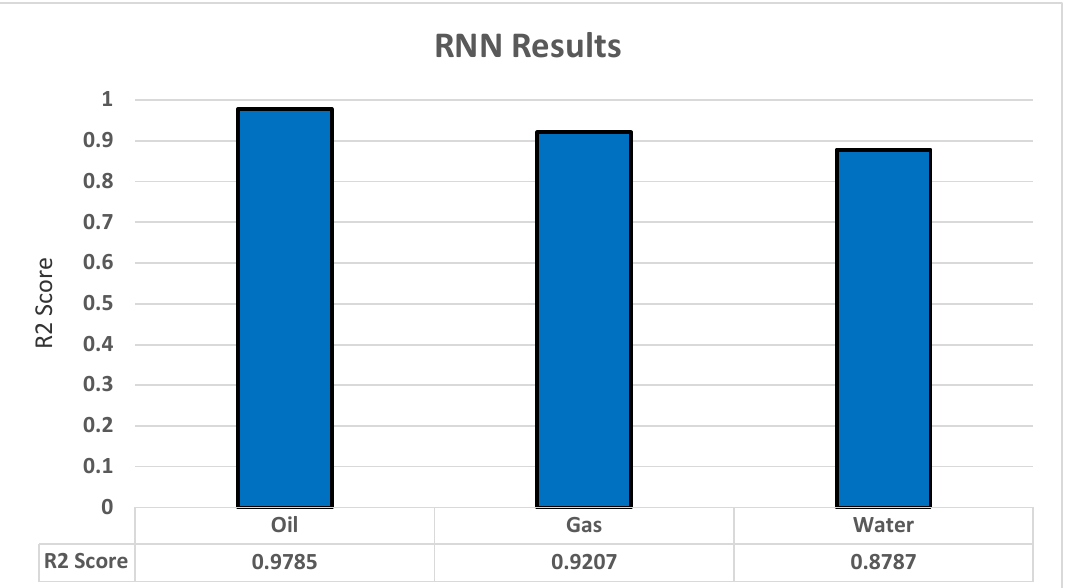
RNN: Comparison of R2 scores for oil, gas, and water Figure 11. RNN’s R2 score results.